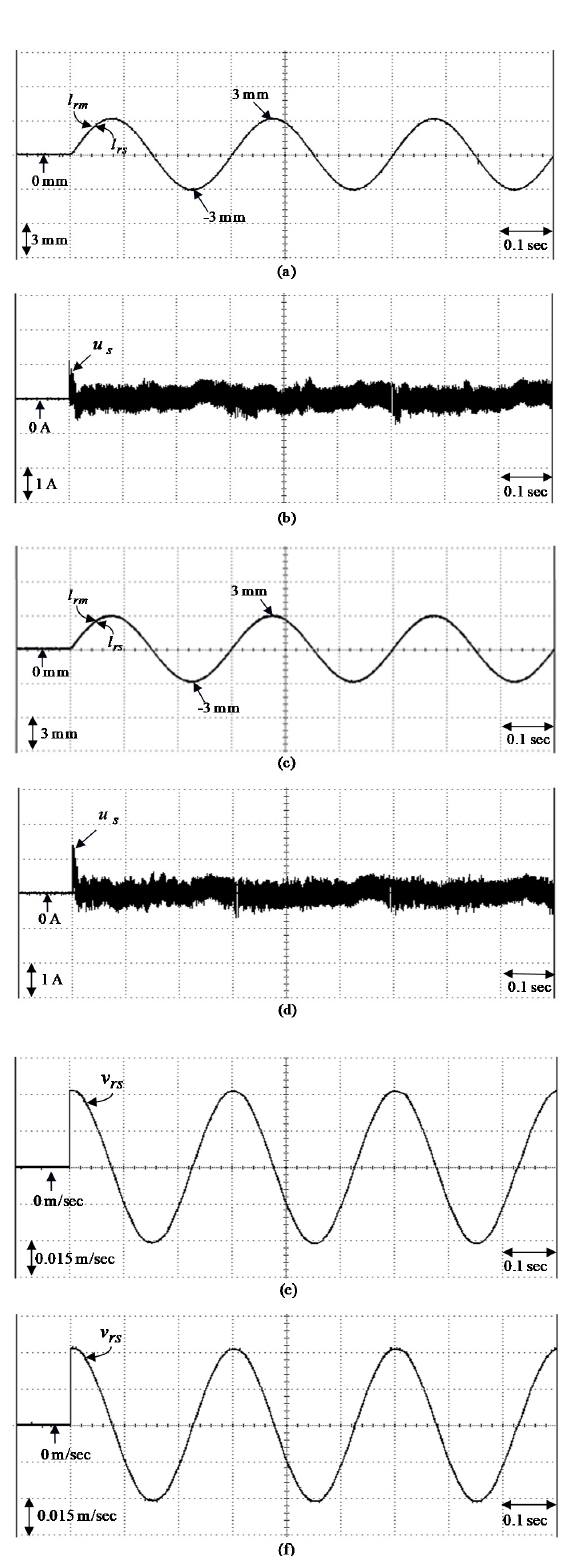
Figure 11. Tested results utilized by the control system K2: ( a ) mover position response at Situation Q3, ( b ) control propulsion response at Situation Q3, ( c ) mover position response at Situation Q4, ( d ) control propulsion response at Situation Q4, ( e ) mover velocity response at Situation Q3, ( f ) mover velocity response at Situation Q4.